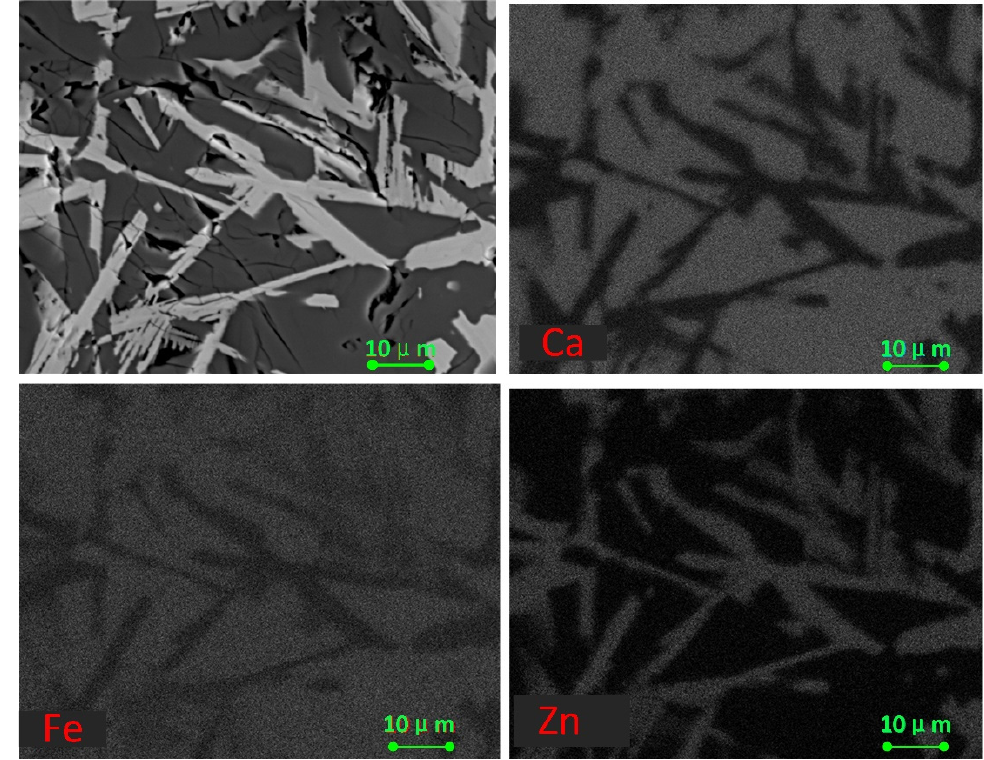
Figure 8. Main element distribution of the roasted product with the roasting time of 1 h.